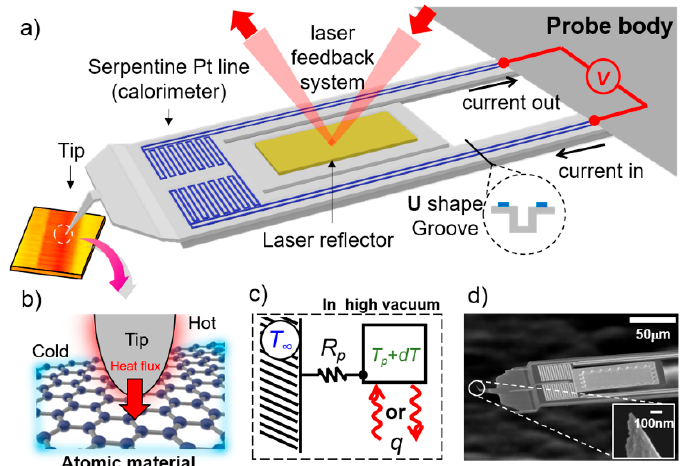
Figure 2. ( a ) Schematic illustration of the pW-SThM. Calorimeter composed of a serpentine platinum line is present in the probe. Temperature of the probe is measured by monitoring the electrical resistance of the metal line. ( b ) Schematic diagram of heat transfer between the probe and substrate. When the tip (at the end of probe) and the substrate make contact, heat transfer occurs through nano-scale channels. ( c ) Schematic of the temperature change of the probe due to change in its thermal resistance caused by heat flux in high vacuum. T ∞ , T p , d T , q , and R p are the room temperature, temperature of the SThM probe, temperature change, heat flux, and thermal resistance of the SThM probe, respectively. ( d ) Scanning electron microscopy (SEM) images of the fabricated SThM probe. The tip of the probe is very sharp with a diameter less than ~100